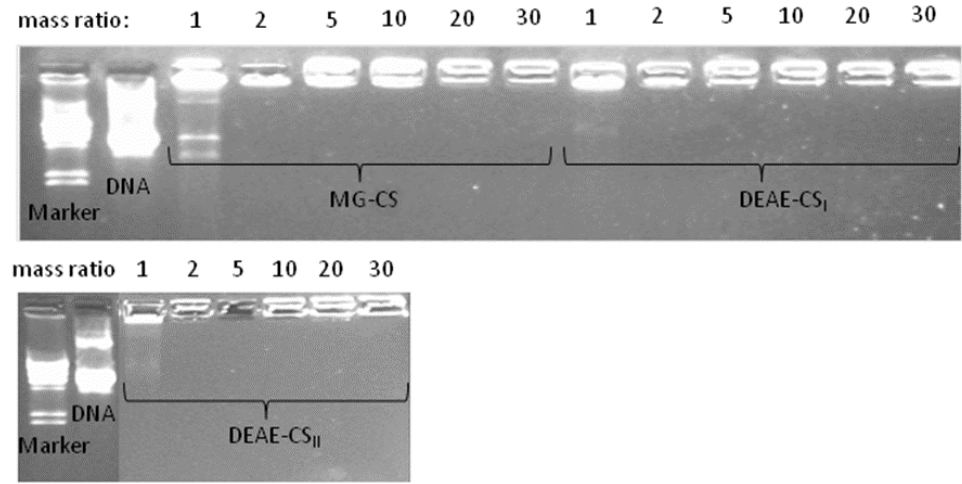
Figure 4. Gel retardation analysis of polysaccharide: DNA mixtures at mass ratios of 1:1, 2:1, 5:1, 10:1, 20:1, and 30:1.